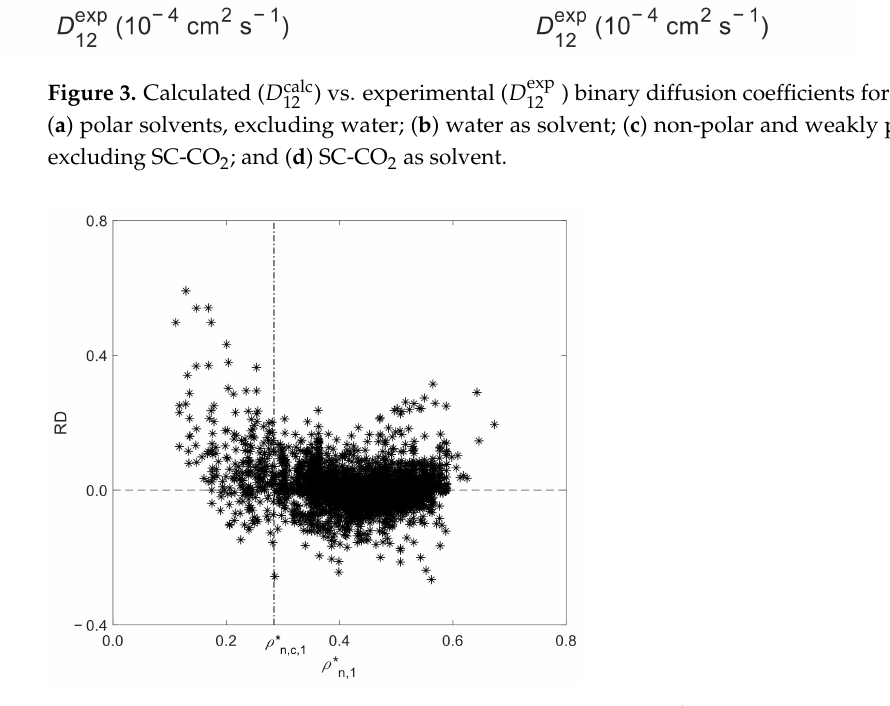
) of the SC-CO 2 diffusivity subset. n,1 ) n,1,c